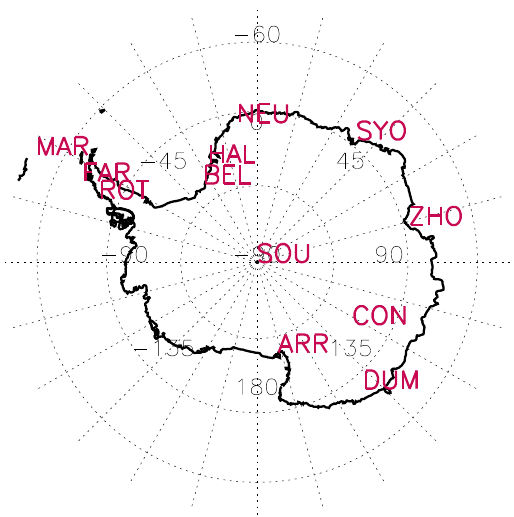
Fig. 1. The stations in the Antarctic from which the measurements are taken for this study. The stations are represented by their first three letters and details of which are given in Table 1.